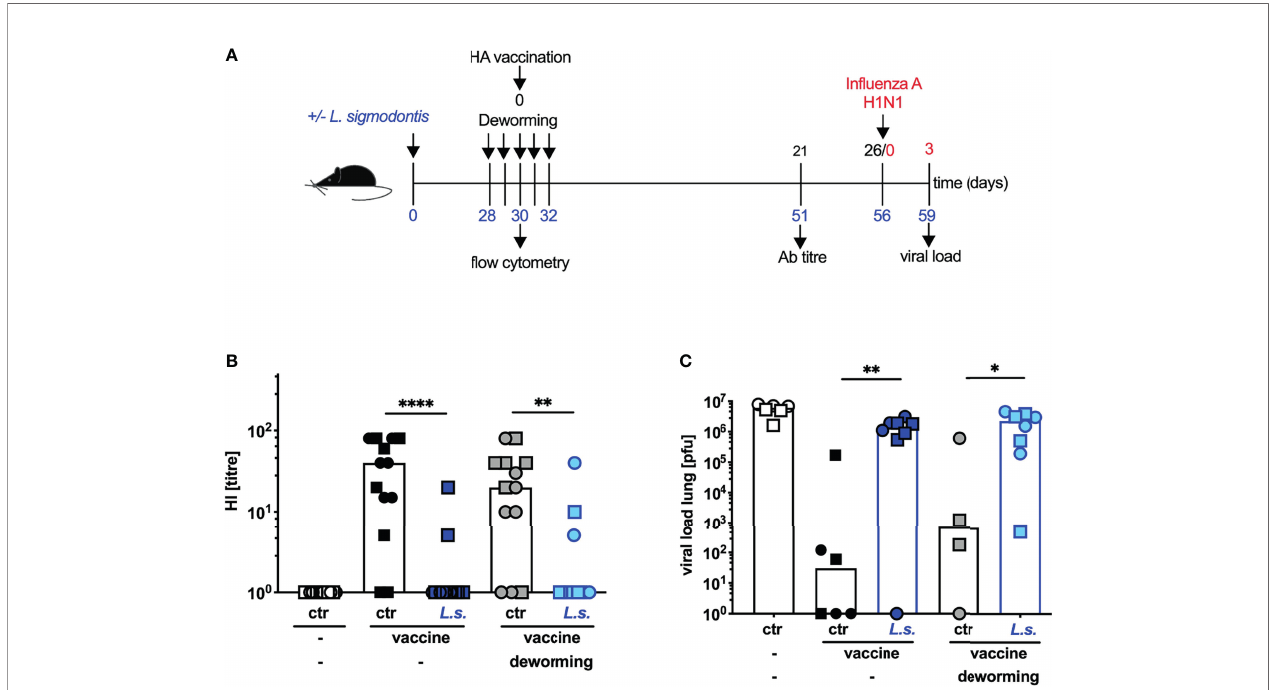
FIGURE 1 | Deworming at the moment of vaccination does not restore the ef fi cacy of vaccination against in fl uenza. (A) Experimental design: Blue numbers indicate time post L. sigmodontis infection, black numbers indicate time post deworming and red numbers indicate time post 2009 pH1N1 in fl uenza A virus challenge infection. C57BL/6 mice were left naive (white, black and grey symbols) or naturally infected with L. sigmodontis (dark and light blue symbols). Mice were dewormed by daily s.c. FBZ injection for 5 consecutive days on day 28 p.i. until day 32 p.i. (grey and light blue symbols) or were left untreated. Deworming ef fi cacy is shown in Supplementary Figure S1 . Mice were i.p. vaccinated with non-adjuvanted in fl uenza vaccine Begripal at day 30 post L. sigmodontis infection or were left unvaccinated (white symbols). (B) HI titres were quanti fi ed 21 days after vaccination. (C) All mice were i.n. infected with 1 x 10 3 PFU 2009 pH1N1 in fl uenza A virus 5 days later. Viral load in the lungs was quanti fi ed day 3 post challenge infection by MDCK plaque assay. Shown are combined results out of 2 independent experiments with (B) n ≥ 6 and (C) n ≥ 3 (2 for the helminth-free and FBZ-treated group) per group and experiment. Each symbol represents an individual mouse, squares and circles represent independent experiments, the bars show the median and asterisks indicate statistically signi fi cant differences applying Mann-Whitney test (* p ≤ 0.05, ** p ≤ 0.01, **** p ≤ 0.0001). ( L. sigmodontis , Litomosoides sigmodontis ; s.c., subcutaneous; FBZ, Flubendazole; p.i., post infection; i.p., intraperitoneal; HI, hemagglutination inhibition; i.n., intra nasal; PFU, plaque forming units; MDCK, Madin-Darby canine